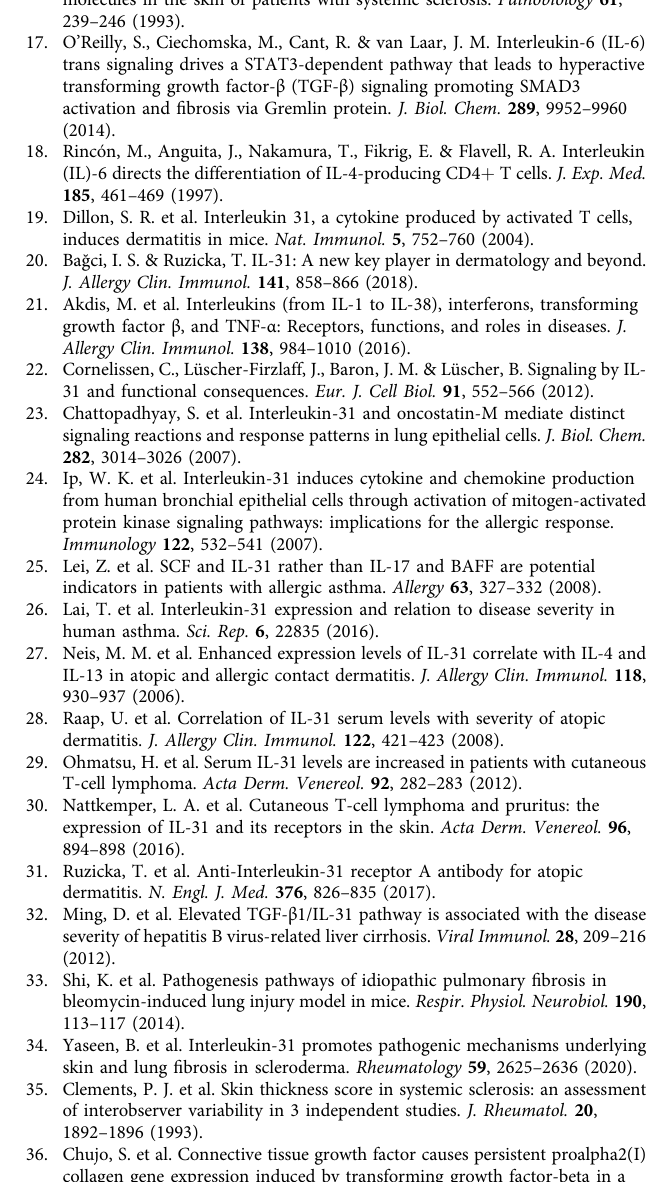
Fig. 9 Anti-IL-31RA antibody attenuated Th2 polarization in BLM-SSc mice. a – c The frequencies of Th1, Th2, Th17, and Treg cells in BLM-SSc and PBS- treated control (PBS-Ctrl) mice administrated with anti-mouse IL-31RA antibody ( α IL-31RA) or isotype control IgG (iso) were analyzed by fl ow cytometry in spleen ( a ), lung ( b ), and lung-draining lymph nodes ( c ). Exact p values (PBS-Ctrl + iso vs. BLM-SSc + iso, PBS-Ctrl + iso vs. BLM-SSc + α IL-31RA, BLM- SSc + iso vs. BLM-SSc + α IL-31RA) = 0.649, 0.769, 0.978 (Th1, spleen); 0.0006, 0.269, 0.010 (Th2, spleen); 0.010, 0.085, 0.463 (Th17, spleen); 0.021, 0.026, 0.994 (Treg, spleen); 0.006, 0.674, 0.027 (Th2/Th1 ratio, spleen); 0.005, 0.020, 0.712 (Th17/Treg ratio, spleen); 0.0002, 0.042, 0.019 (Th2/ Treg ratio, spleen); 0.547, 0.830, 0.878 (Th1, lung); 0.000004, 0.032, 0.0002 (Th2, lung); 0.002, 0.005, 0.768 (Th17, lung); 0.042, 0.040, 0.999 (Treg, lung); 0.00001, 0.052, 0.0006 (Th2/Th1 ratio, lung); 0.006, 0.010, 0.957 (Th17/Treg ratio, lung); 0.0000003, 0.003, 0.00004 (Th2/Treg ratio,